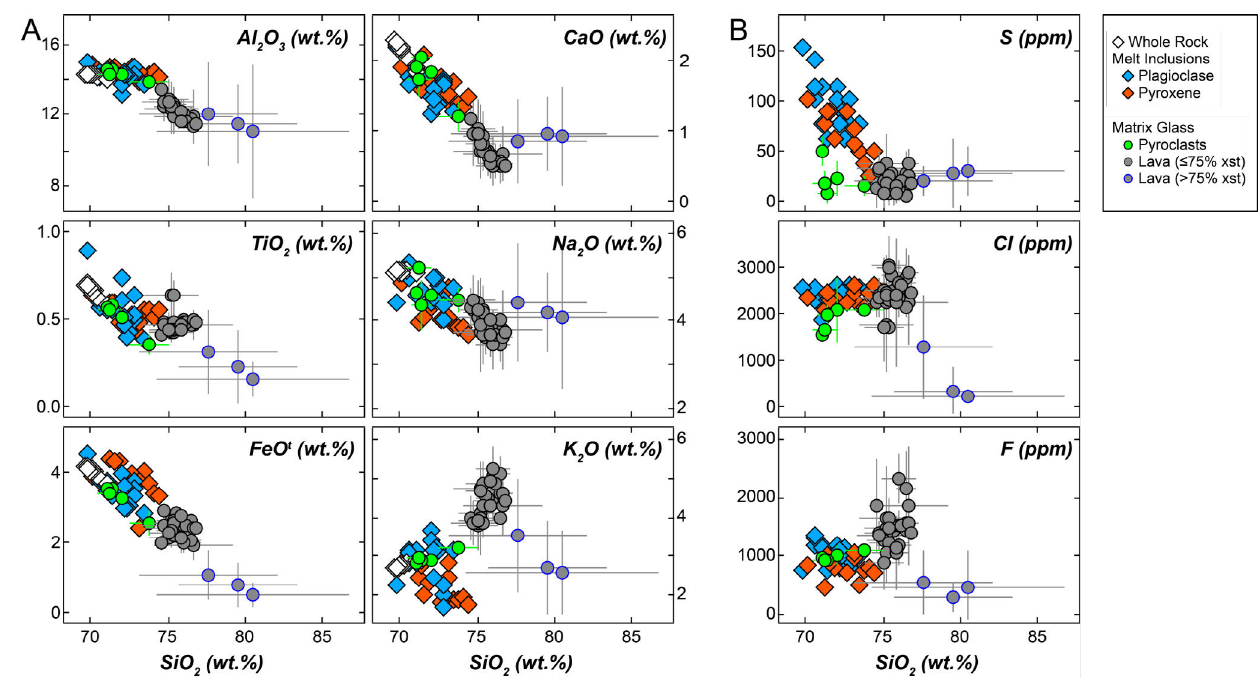
Figure 6: [A] Major elements and [B] volatiles versus SiO . Whole-rock and inclusion analyses represent individ- 2 ual points. Matrix glasses are plotted as averages with error bars denoting ± 1 standard deviation. Error bar sizes tend to be larger in more microcrystalline lava samples, indicating higher degrees of intra-sample compositional variability. Major elements are normalised to 100%, volatile-free. All data given in Supplementary Material.